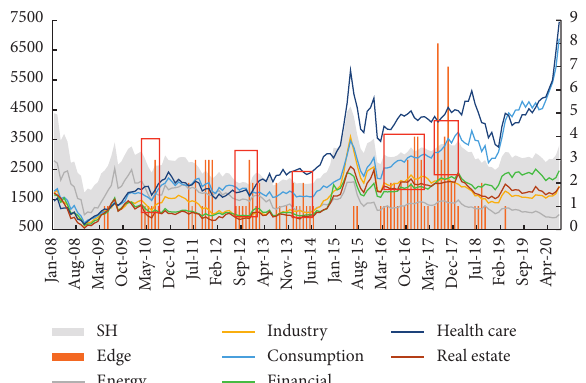
Figure 2: The Shanghai Composite Index and industry indices (left ordinate), stable link periods (red box), and system relevance degree (right